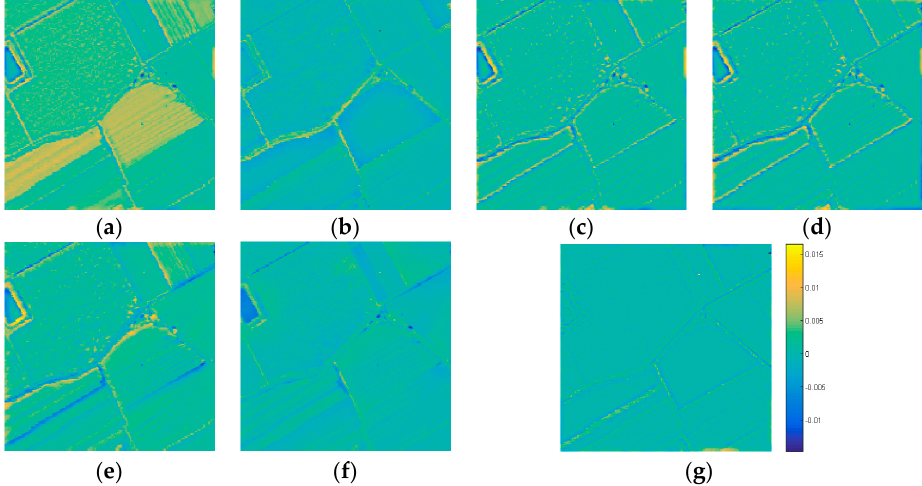
Figure 6. Visual comparison of difference images (light blue means small differences) between each fused HS image and the reference HS image (Salinas dataset). ( a ) PCA; ( b ) GFPCA; ( c ) HySure; ( d ) MGH; ( e ) CNMF; ( f ) Sparse Representation; ( g ) Proposed. Table 1. Quality metrics of different methods for Salinas